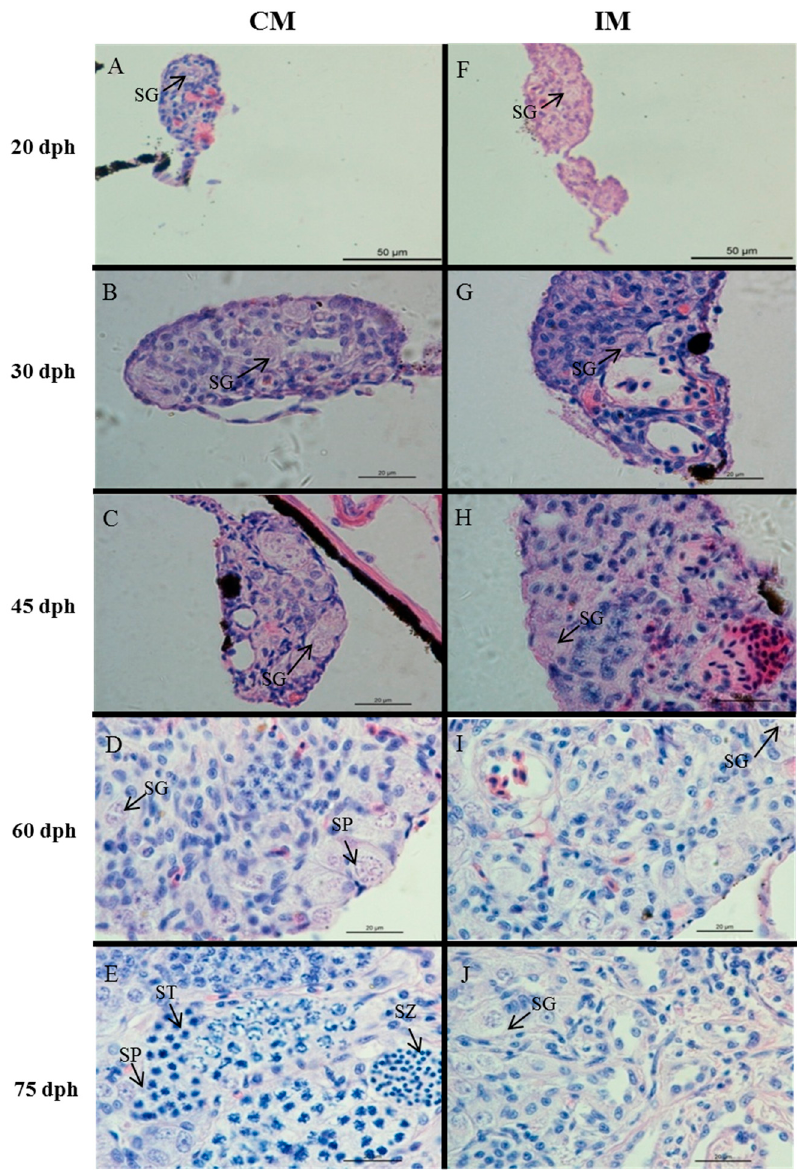
Figure 2. Gonad histology of control males (CM) and high-temperature-induced males (IM) at various developmental stages. ( A – E ): gonad of 20–75 dph control males; ( F – J ): gonad of 20–75 dph high-temperature-induced males; SG: spermatogonia; SP: spermatocyte; ST: spermatid; SZ: spermatozoa; dph: days post-hatching.